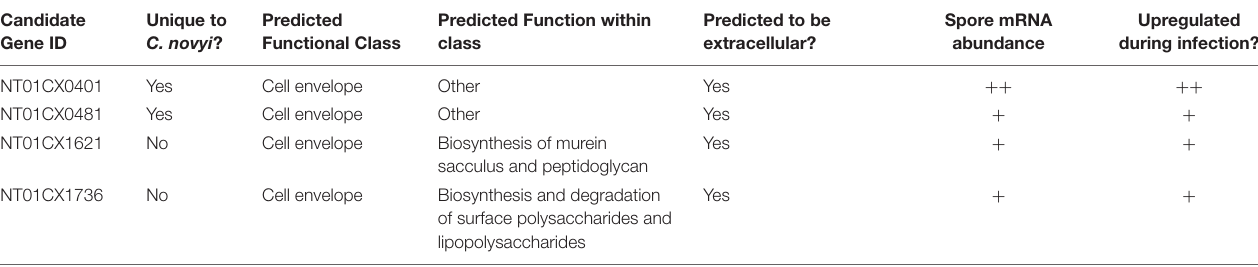
TABLE 1 | Table indicating the chosen C. novyi genes to target CRISPR mediated gene insertion and a few of the important characteristics considered when selecting these targets. Candidate Unique to Gene ID C. novyi